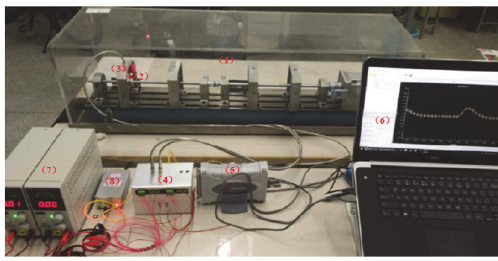
Figure 6: Optical fiber tip clearance measurement system test rig.